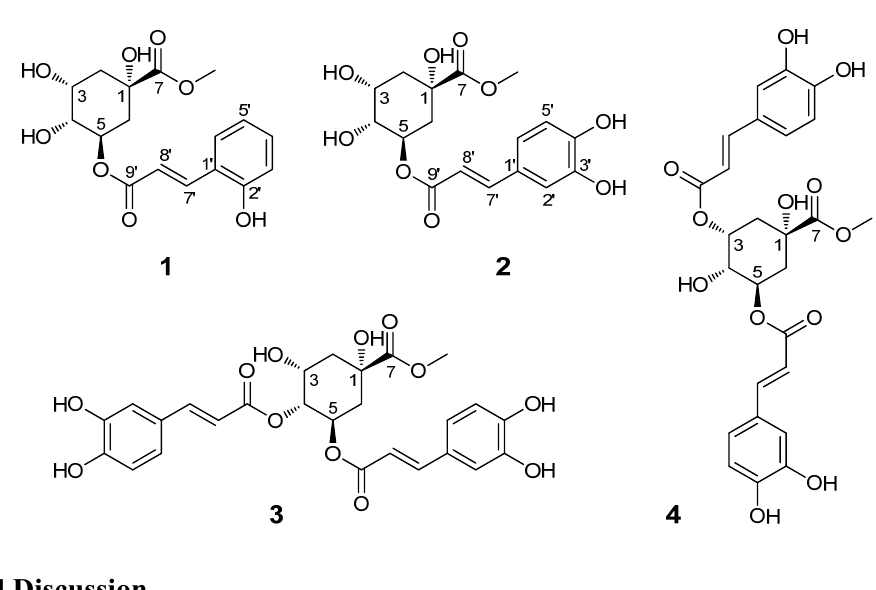
Figure 1. Chemical structures of compounds 1 − 4